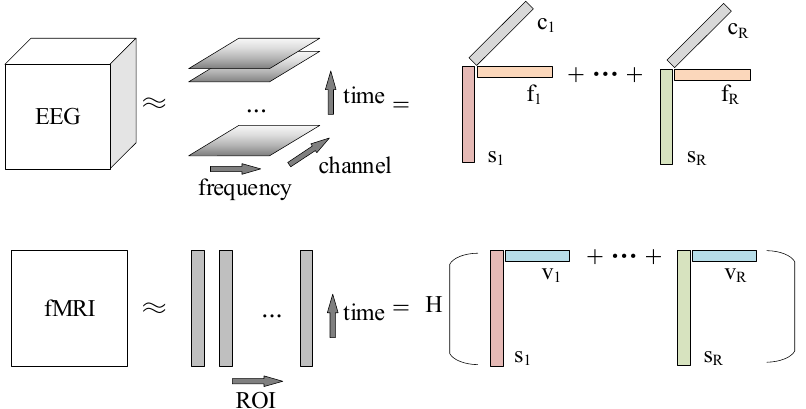
Figure 4. The CMTF method decomposes the sources shared in both modal data. The EEG tensor is decomposed into R components, each consisting of a temporal signature s r , spectral signature f r , and spatial (channel) signature c r . The fMRI data are decomposed into a convolution of R components and HRF, each consisting of a temporal signature s r and spatial (ROI) signature v r